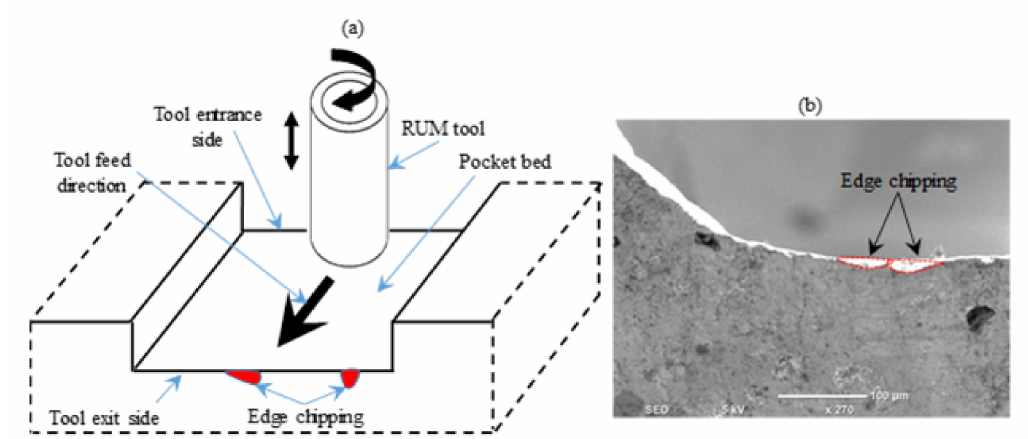
Figure 10. Edge chipping analysis, ( a ) illustration of the chipping spots, ( b ) an example of an outlet edge